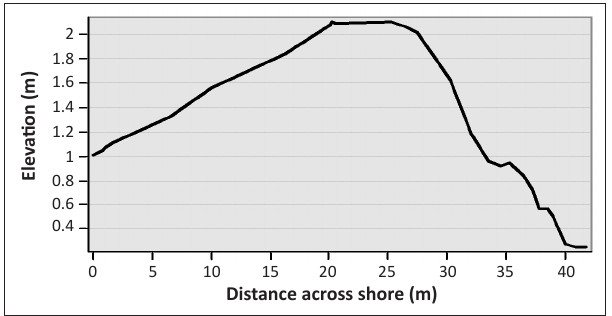
FIGURE 8: Cross-shore profile on part of the eastern beach.